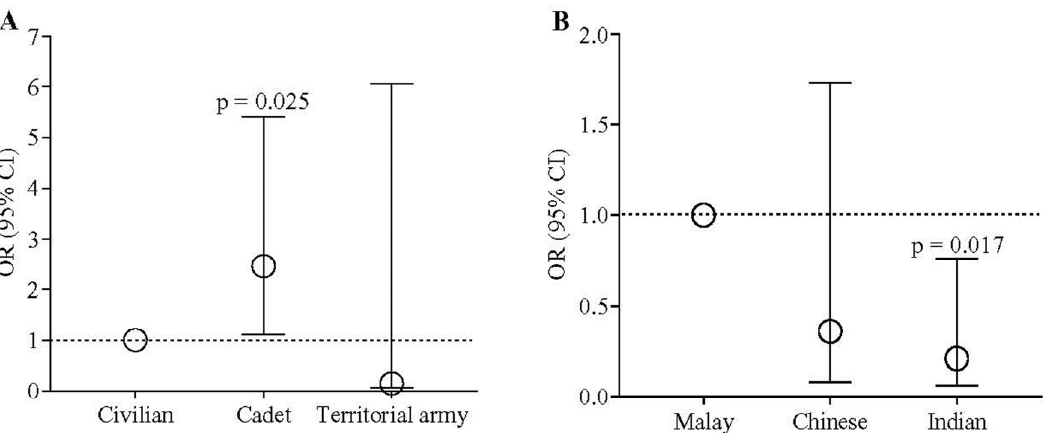
Figure 8. Odds of designation and ethnicity of the participants regarding the knowledge of prescrib- ing guidelines. Logistic regression was used to estimate the p -value. Circles indicate the estimate of odds